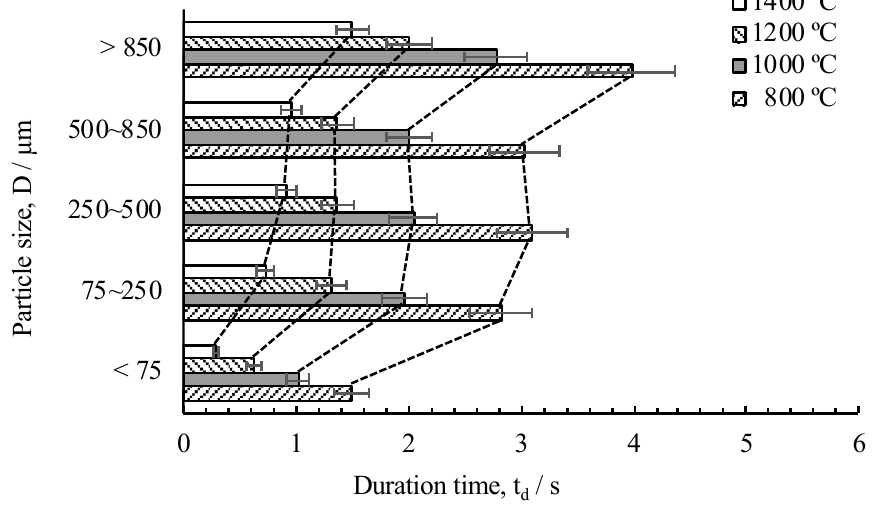
Figure 11. Evaluation of the dependency of the duration time of the exothermic reaction on the particle size as a function of increased temperature.